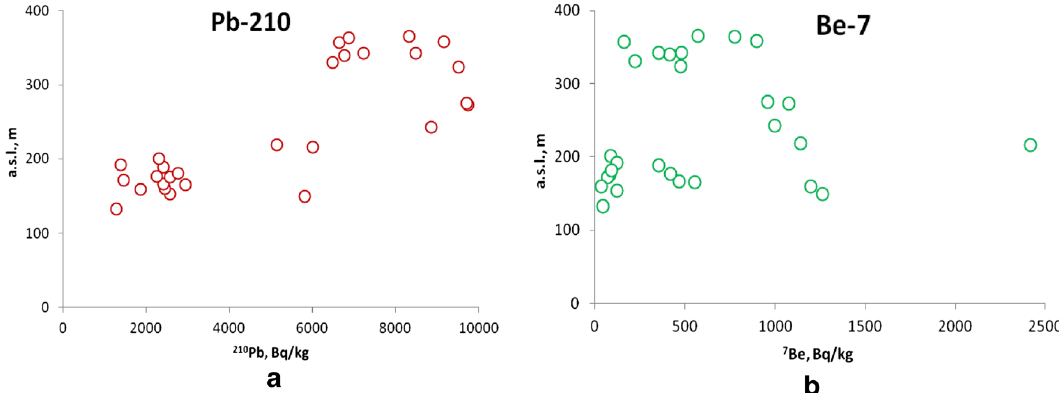
Figure 6. Distribution of specific activity of 210 Pb ( a ) and 7 Be ( b ) in Nalli Glacier cryoconite depending on altitude above sea